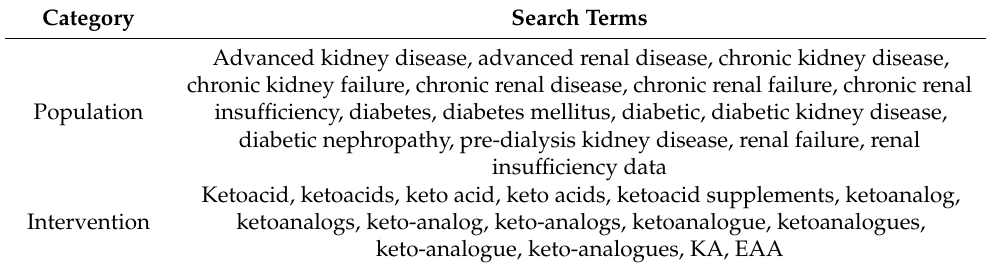
Table 1. Summary of search terms